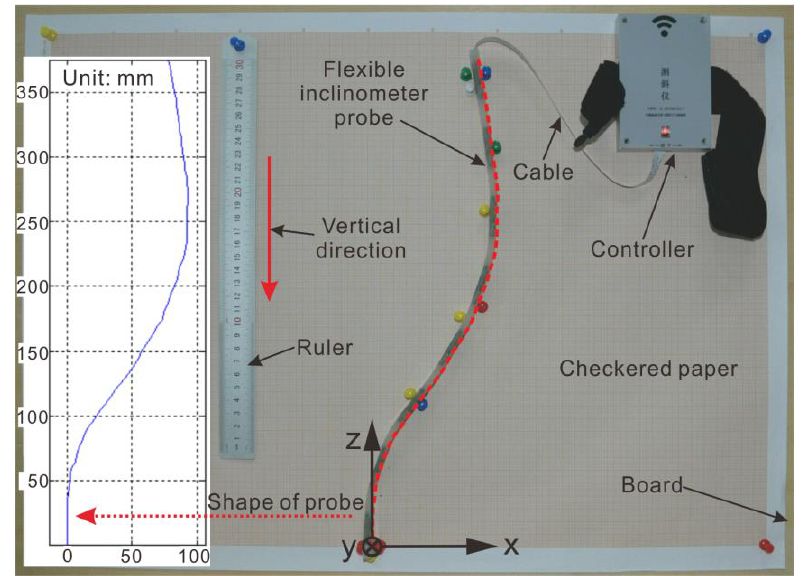
Figure 5. Verification method of measurement results for the flexible inclinometer probe.